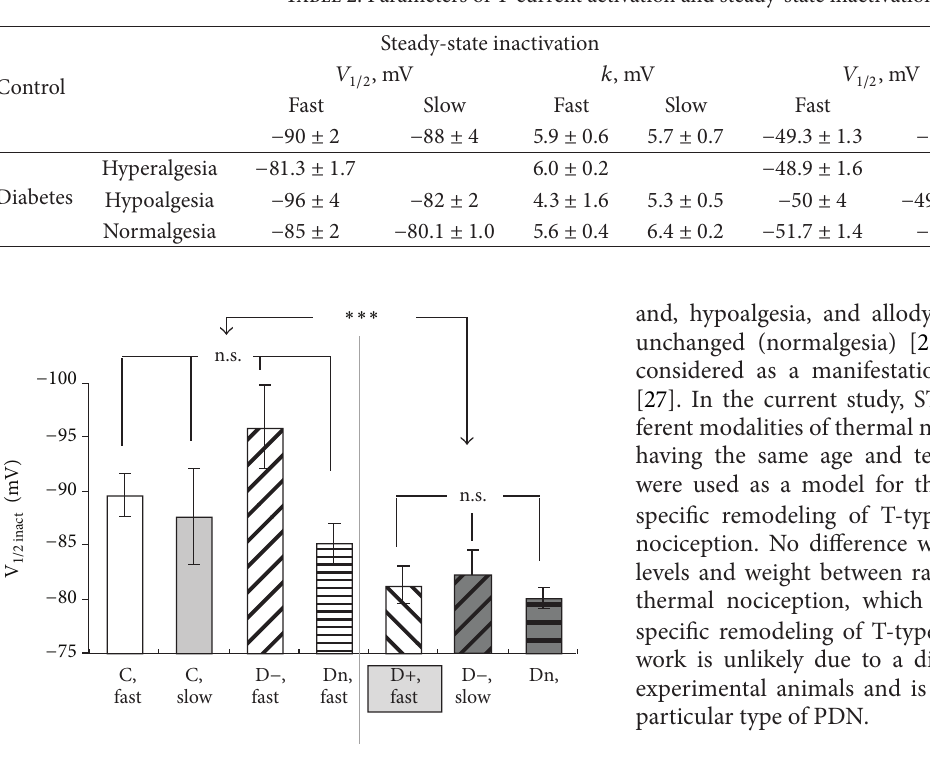
Table 2: Parameters of T-current activation and steady-state inactivation.